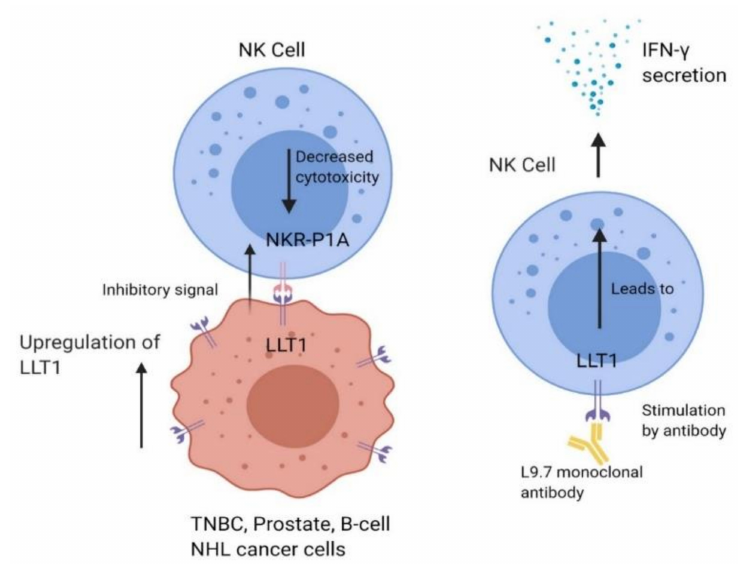
Figure 2. LLT1 is expressed on specific tumor cells such as triple-negative breast cancer (TNBC), prostate cancer, and B-cell non-Hodgkin’s lymphoma (NHL) cells. LLT1 on tumor cells interacts with NKR-P1A on NK cells, sending an inhibitory signal to NK cells which decreases cytolytic function. Cancer cells have also been shown to upregulate LLT1 expression to increase the immune dampening e ff